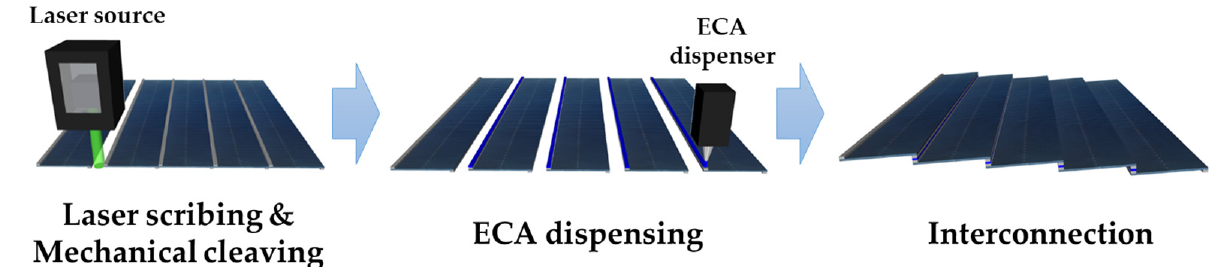
Figure 1. Schematic of the shingled-type cell-to-string structures and fabrication process.